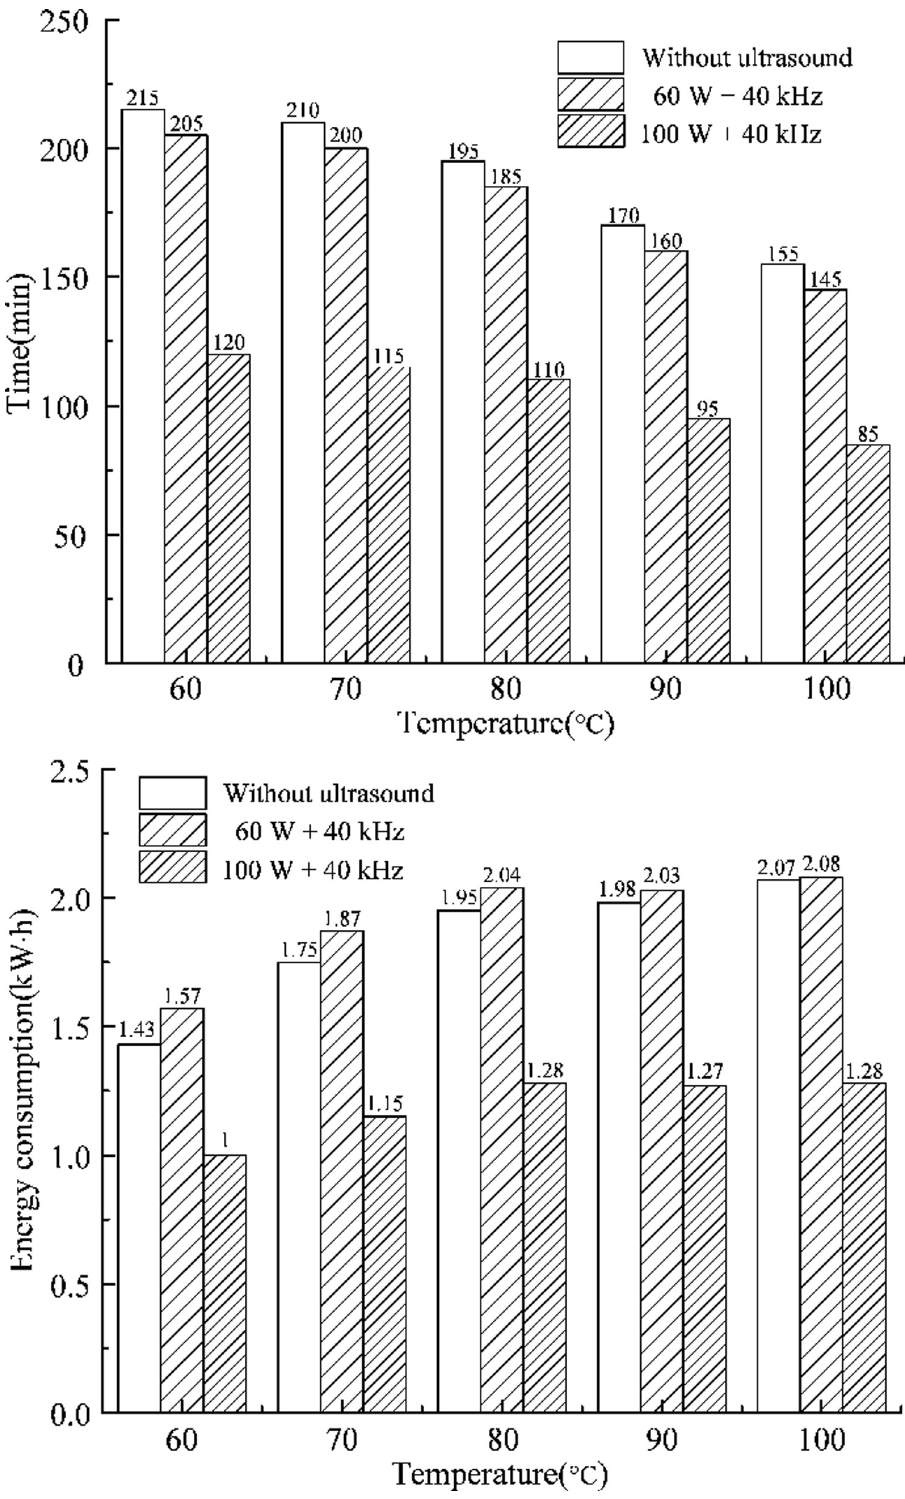
Fig 7. Drying time and energy consumption. (a) Drying time (b) Energy consumption.